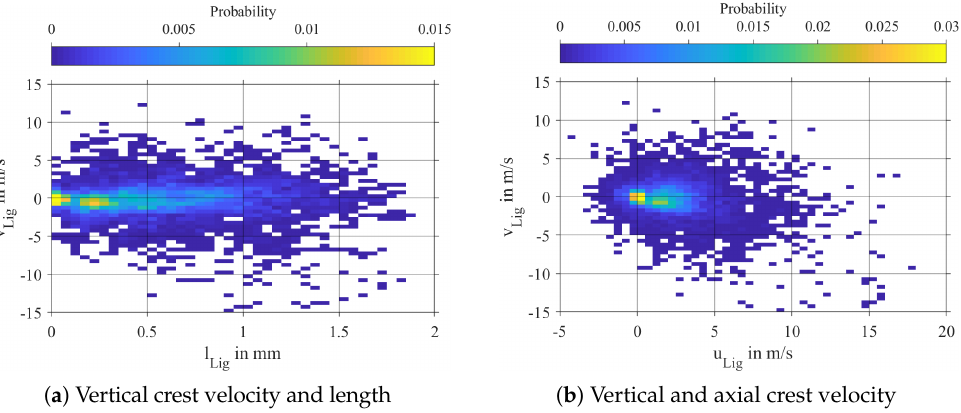
Figure 10. Interdependencies of the vertical crest velocity for p g = 5bar, u g = 70m/s, h a =